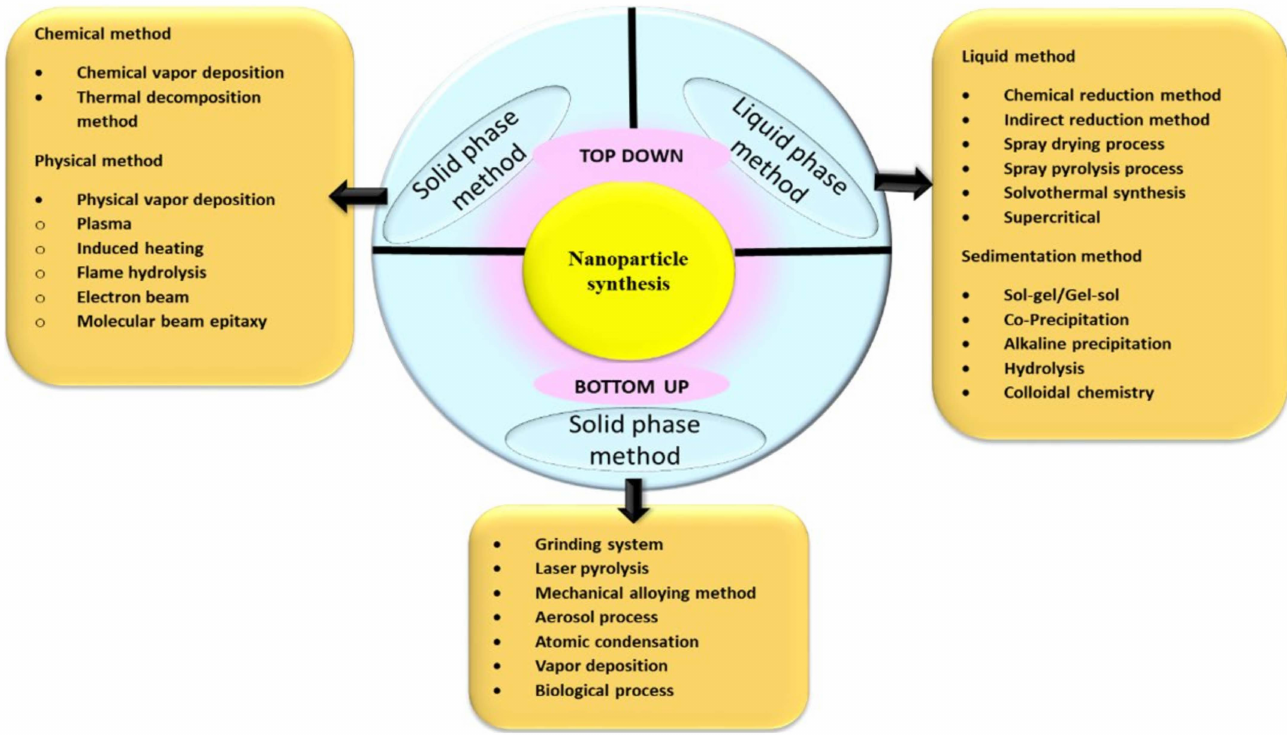
Figure 1. Various approaches for the synthesis of